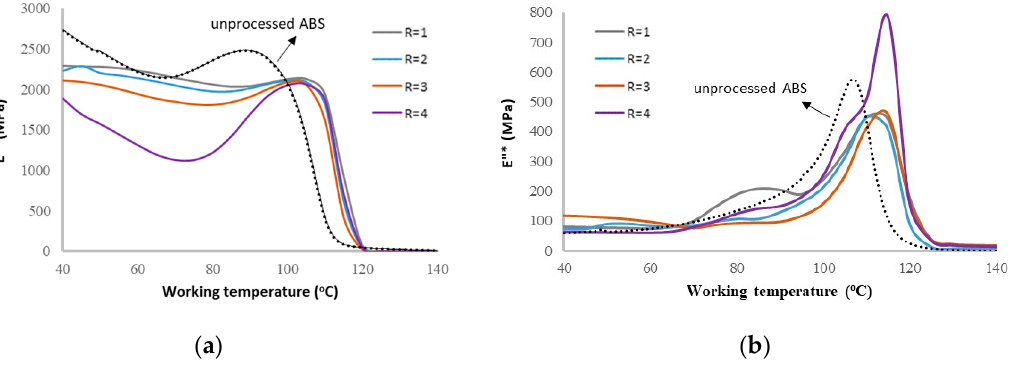
Figure 15. Comparison of the optimized ( a ) storage and ( b ) loss moduli of the prints, as compared to the parent (unprocessed) material, at different working temperatures and raster orientations (R). 4 levels provided for R are corresponding to the levels presented in Table 2.